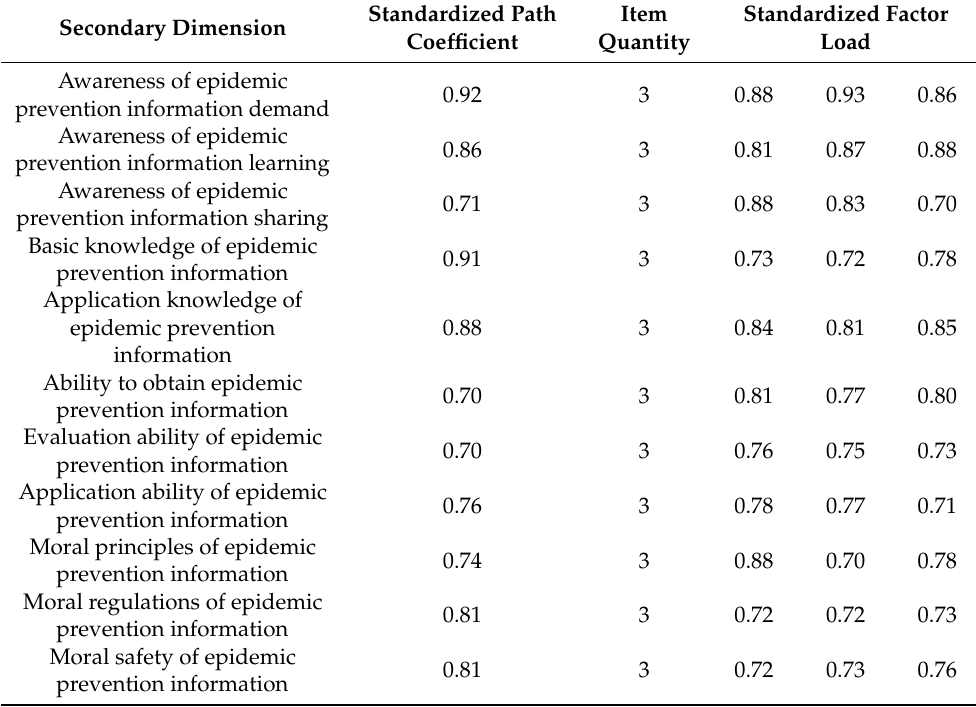
Table 1. Factor load matrix of second-order